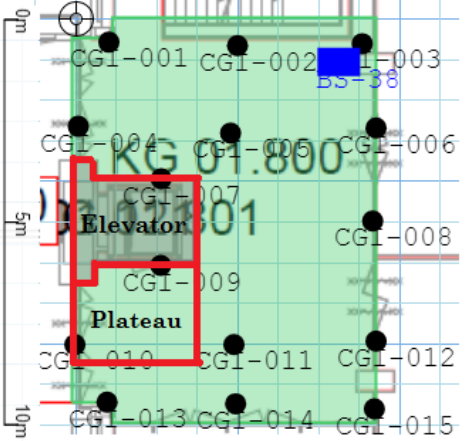
Figure 4. The test area (green) with the locations of the beacons (black), basestation (blue) and the elevator shaft (red).